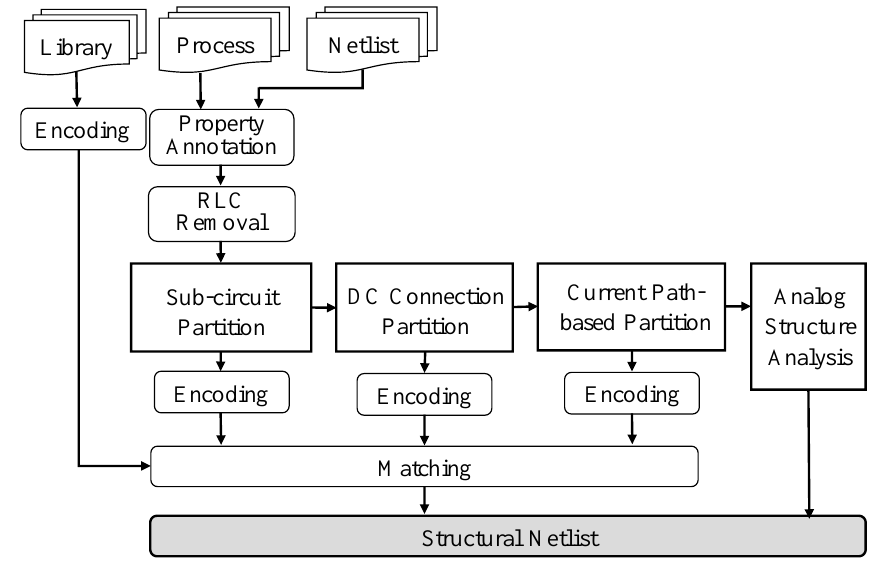
Figure 2. Overall hierarchical structure recognition flow for system-level behavior simulation.